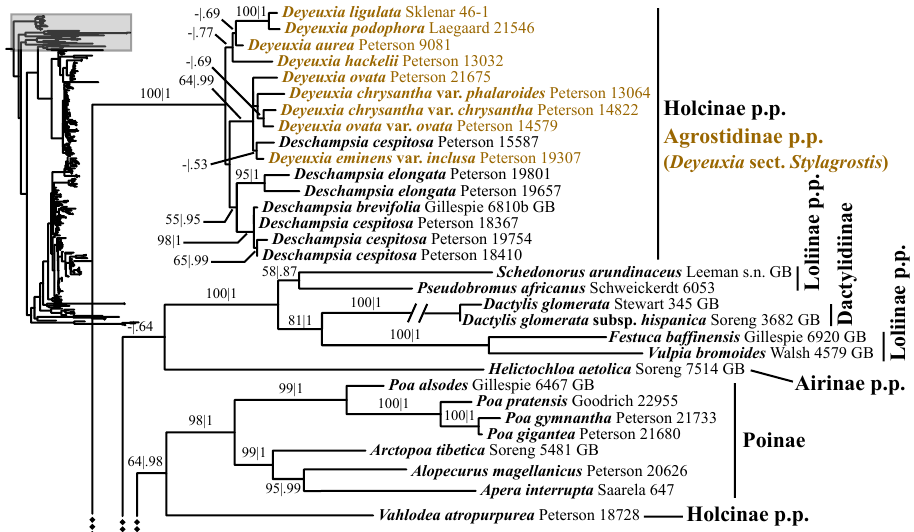
Figure 4. A portion (Holcinae p.p., Agrostidinae p.p., Loliinae, Dactylidinae and Poinae) of the max- imum likelihood phylogram inferred from ITS+ETS data. ML bootstrap support (left) and BI poster probabilities (right) are recorded along branches. A dash indicates bootstrap support <50%. No support is shown for branches with bootstrap support <50% and posterior probability <.5. The shaded area of the smaller tree on the left indicates the location in the overall tree of the portion shown. The branch sub- tending Dactylidinae, with double slashes, is shortened for presentation. Backbone branches represented by ellipses are shown only in Figure